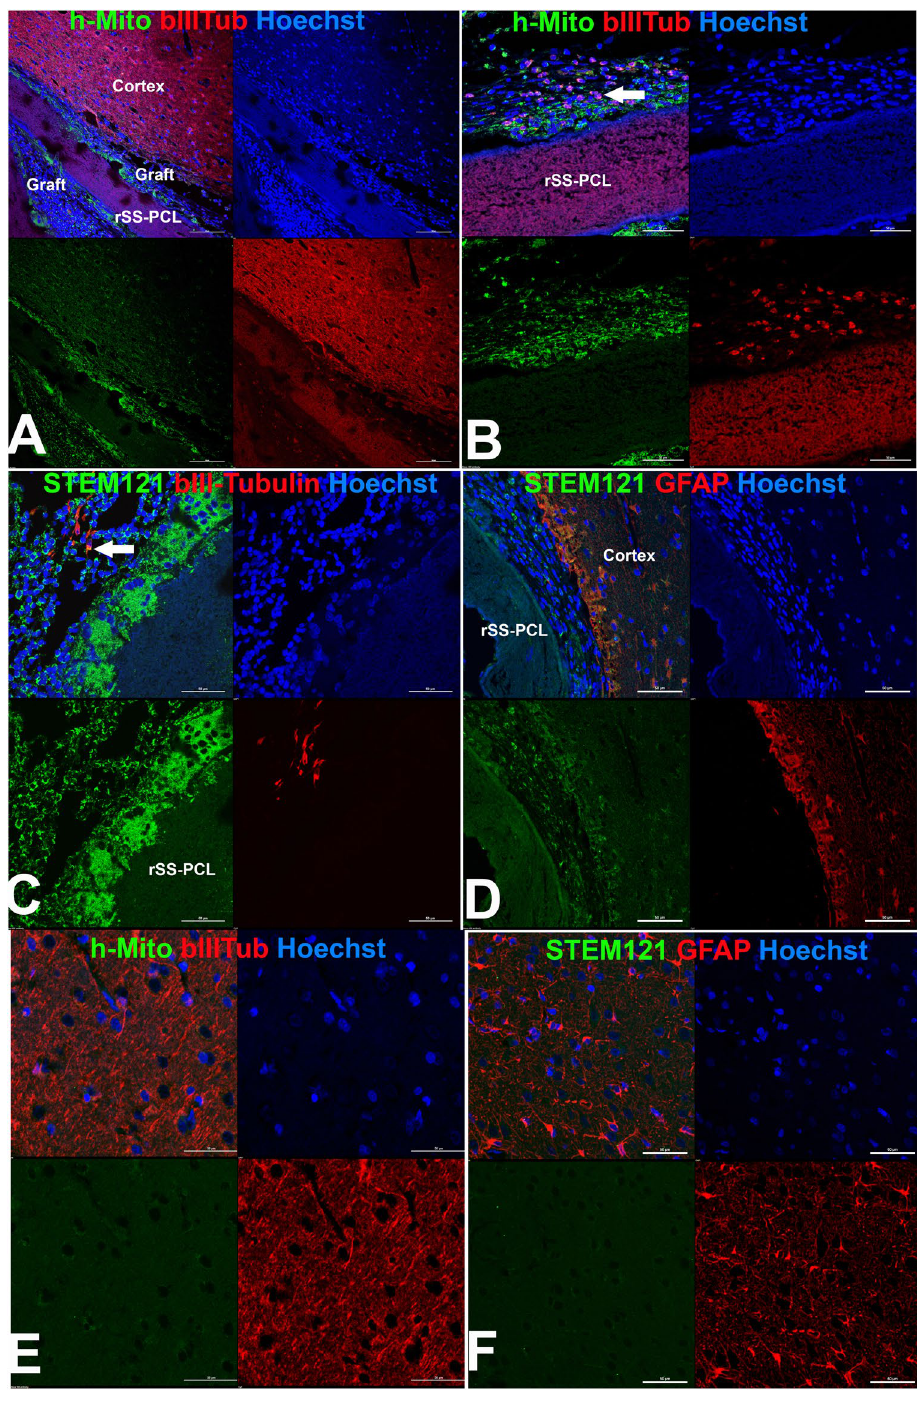
Figure 7. Immunofluorescence analysis of the brain of a rhesus macaque at the site of implantation of the SPRPix matrix with human drNPC. ( A ) Representative low magnification image of the site of drNPC-SPRPix implantantation showing staining by human specific anti-mitochondria antibodies (h-Mito) and some co- expression with β III-tubulin. ( B ) Higher magnification of h-Mito and β III-tubulin staining. Arrow shows co- localization of h-Mito and β III-tubulin indicating neuronal differentiation of transplanted human drNPCs. ( C ) Human specific staining by STEM-121 co-localized with anti- β III-tubulin (arrow). ( D ) Staining with STEM- 121 and anti-GFAP revealed no co-localization. ( E – F ) Staining of normal brain tissue shows absence of h-Mito ( E ) and STEM-121 ( F ) staining of non-tranplanted NHP host tissue. Bar 100 µ m. Laser scanning confocal